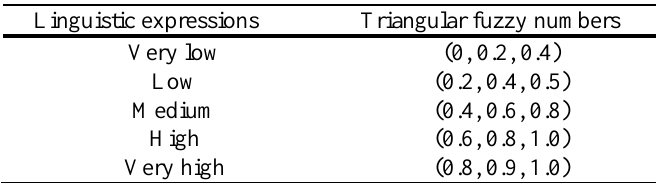
Table 1. The linguistic expressions and their triangular fuzzy numbers.